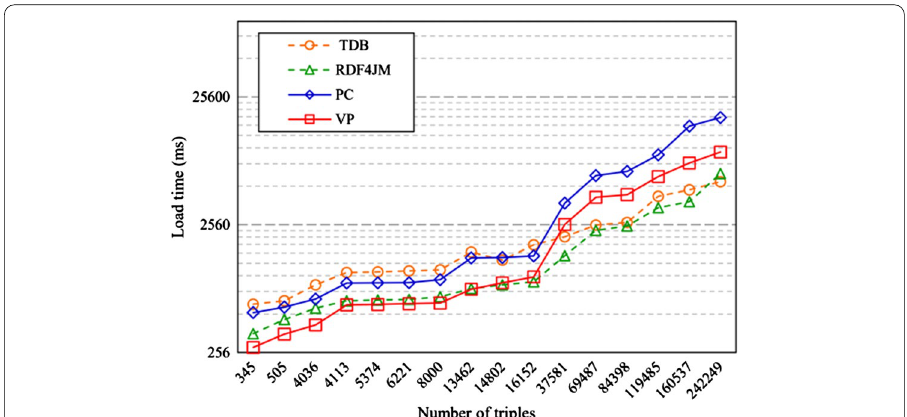
Fig. 8 Load time of the proposed methods against the existing